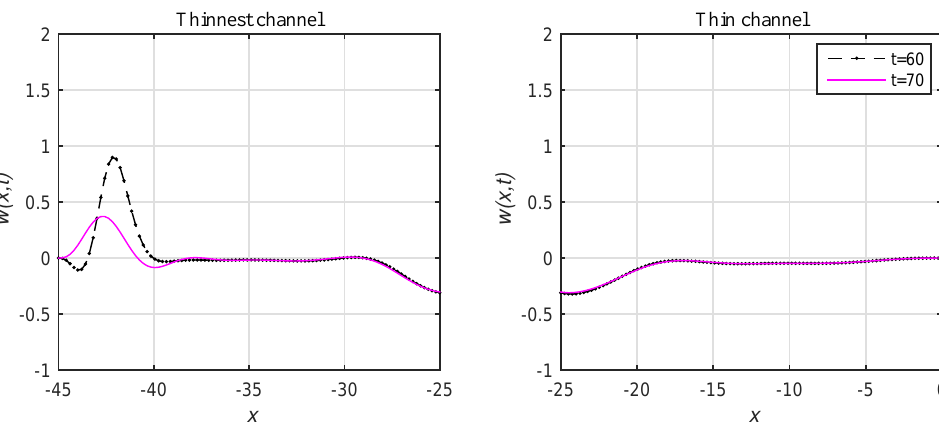
Figure 12. Continuation from Figure 11. t =